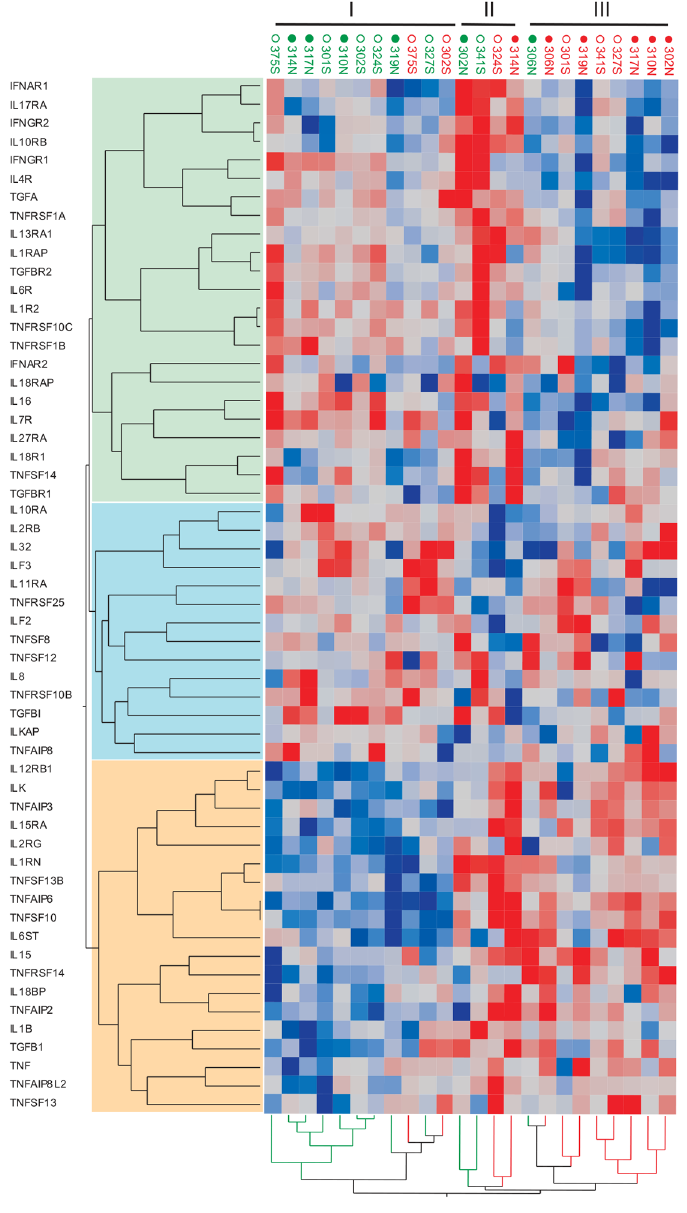
Fig 5. Heat map of Interleukins, Interferon (IFN), Transforming Growth Factor (TGF) and tumor necrosis factor (TNF) genes. All genes with names starting with IL, IFN, TGF or TNF were selected and subject to two-way hierarchical analysis. Red indicates high expression, blue low expression, and gray intermediate. Three groups of samples (I, II and III), and three clusters of genes (green, blue and yellow) are indicated. Baseline (Green labels) and Diagnosis samples (Red labels) are separated, excluding the outlier Cali 306N Baseline sample and 375S and 302S. Solid points represent Cali (N, na ï ve), and open circles represent Buenaventura (S,